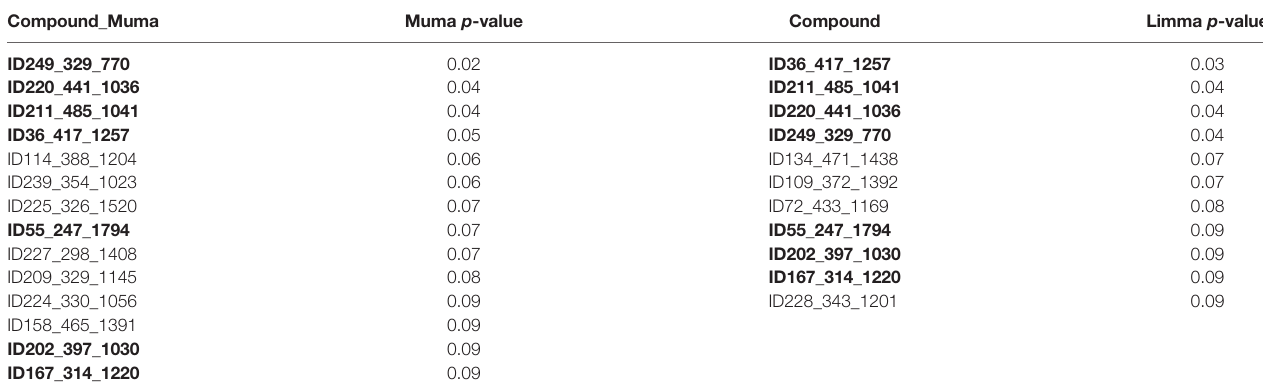
TABLE 2 | Candidate metabolites differentially expressed between PCa and